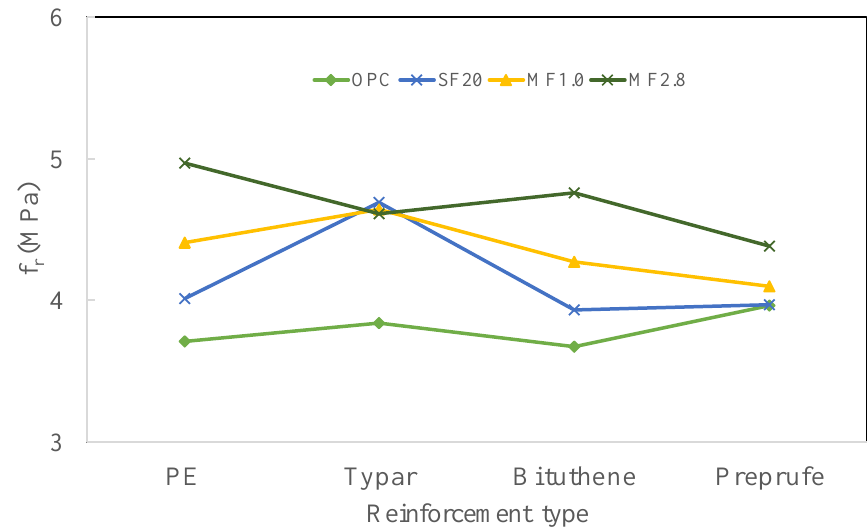
Figure 7. Flexural strength comparison with different types of waterproofing reinforcement.